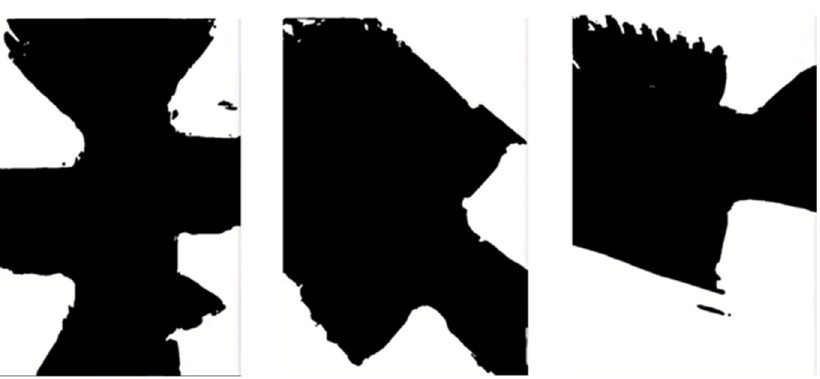
Figure 13. NVIDIA Xavier detection results.